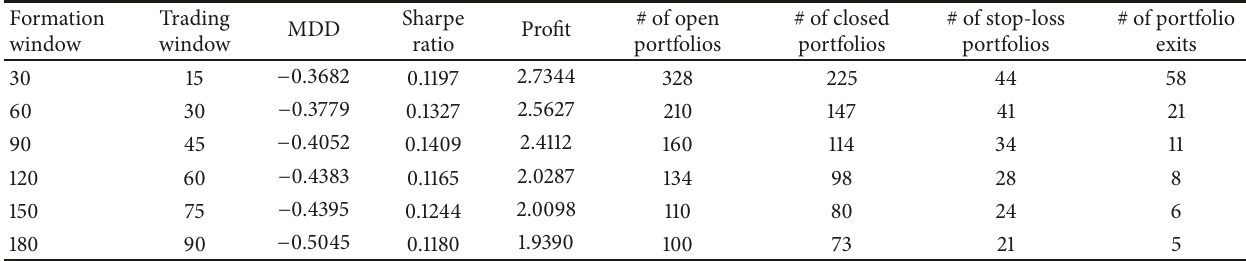
Table 4: Results of applying the DQN method to each window size using OLS.